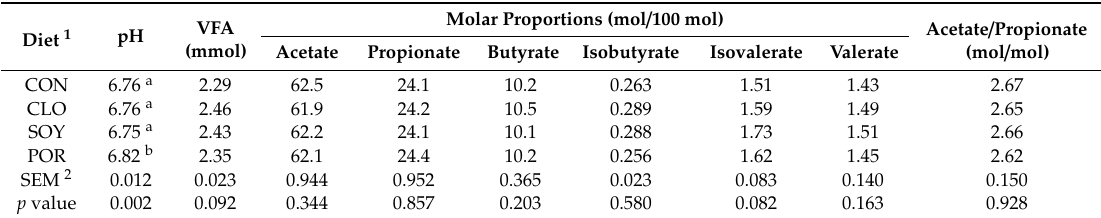
Table 3. Average values of pH, total volatile fatty acids (VFA) produced and molar proportions of individual VFA and acetate:propionate ratios after 24 h of incubation of the experimental diets in batch cultures inoculated with ruminal microorganisms from sheep.